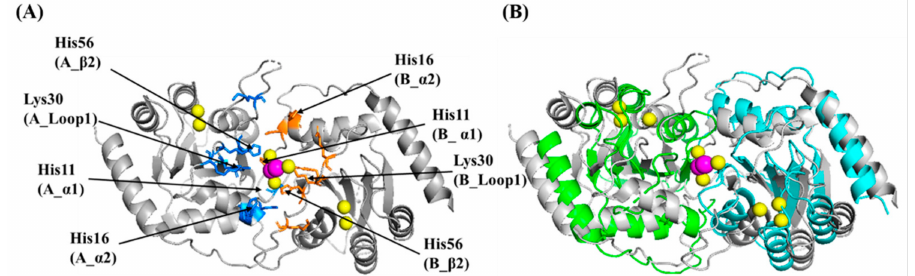
Figure 10. Dimerization interface of A3A-E72A-C171A and A3B CTD *. ( A ) A3A-E72A-C171A homod- imer (PDB 4XXO [49]) (grey) labelled with residues that are important in forming the dimerization interface. A3A molecule A dimerization residues labelled in blue and A3A molecule B dimerization residues labelled in orange. ( B ) Comparison of the A3A-E72A-C171A homodimer (PDB 4XXO [3,49]) (grey) to our dimer interface model 1 of A3B CTD * (molecule A in green and molecule B in cyan). Zn 2+ ions are represented as yellow spheres and chloride ions are shown as magenta